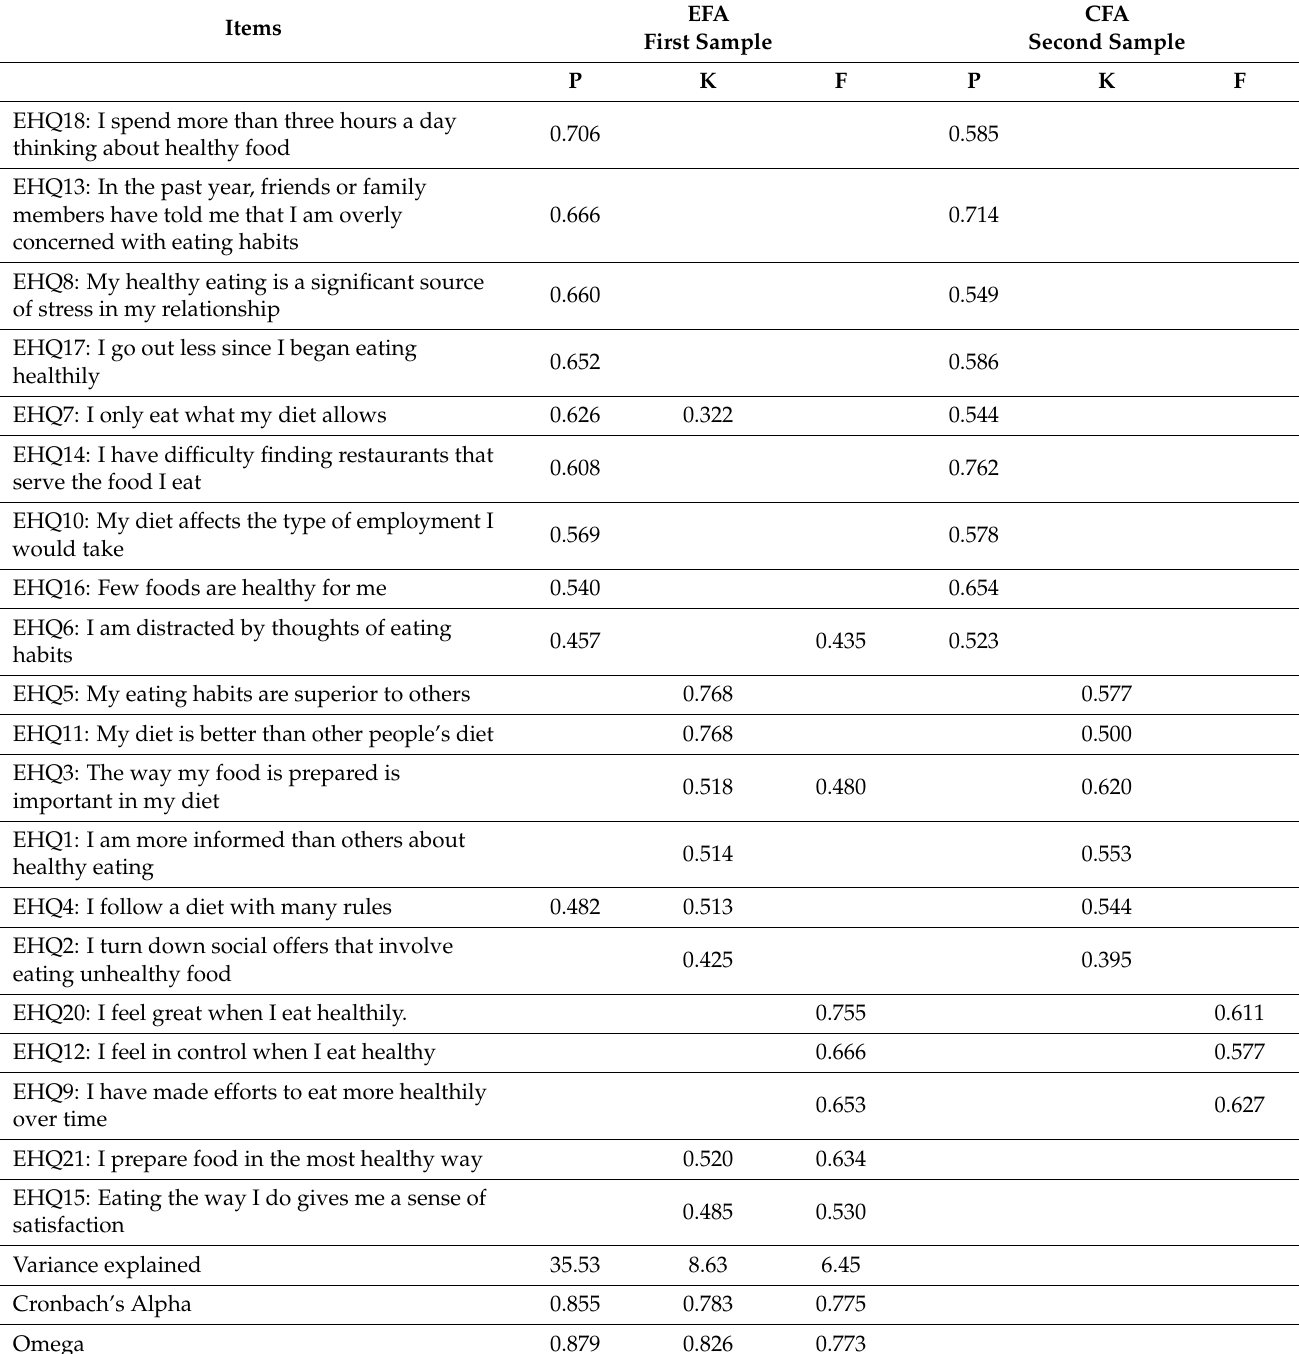
Table 2. Factorial solution of Eating Habits Questionnaire